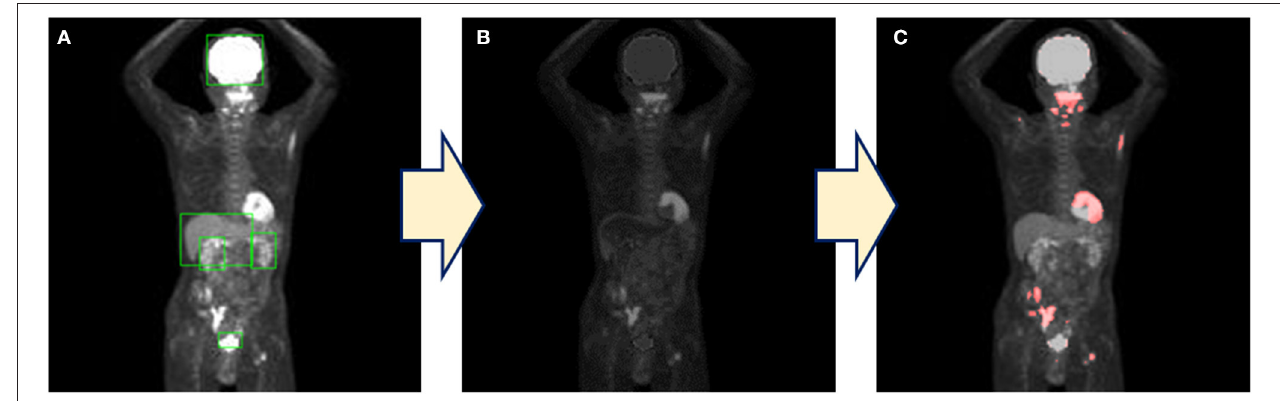
FIGURE 3 | The process of the combination method. (A) The detection of physiological uptake by YOLOv2. (B) Only physiological uptakes detected by YOLOv2 were subtracted from the original images. (C) A color map is generated by coloring the pixels above the